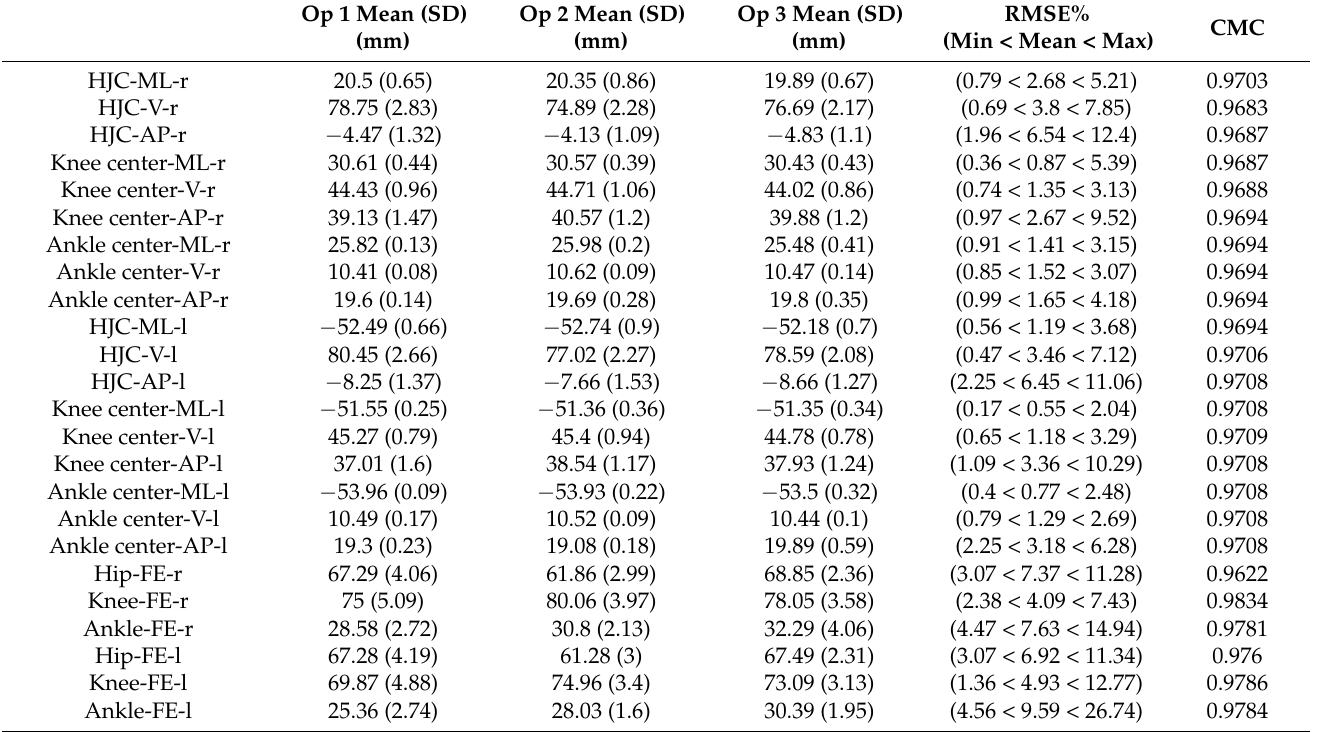
Table 6. Inter-rater repeatability analysis for the joint centers trajectories (top) and joint sagittal angles (bottom) computed with